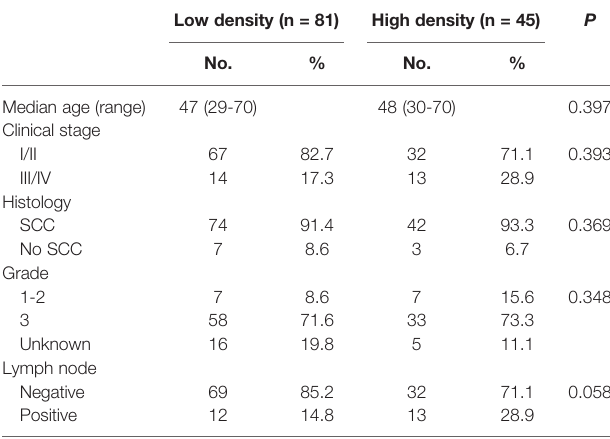
TABLE 5 | Baseline characteristics of patients with cervical cancer in low- and high-density groups of stromal